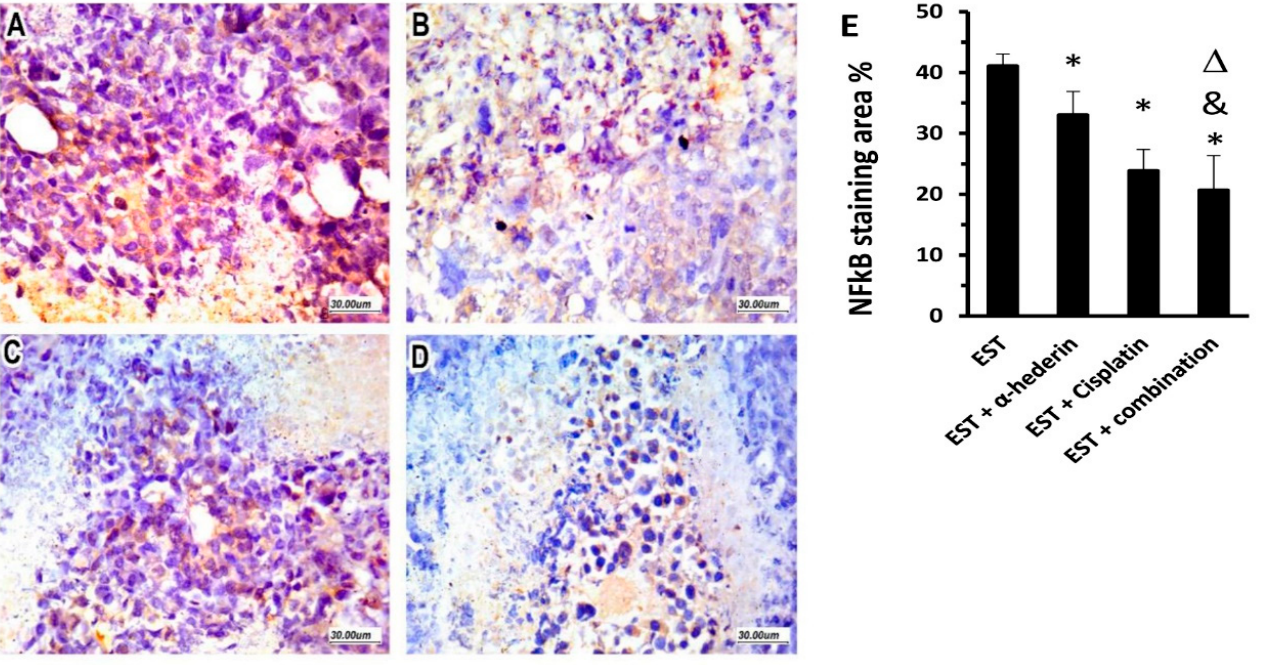
Figure 6. Immunostaining for NF κ B in the study groups . ( A ) Photomicrograph from the EST control group shows marked expression of NF κ B by tumor cells. ( B ) The cisplatin group showed lower expression of NF κ B by tumor cells. ( C ) This image shows the EST + α -hederin group with a moderate expression of NF κ B by tumor cells with areas of necrosis. ( D ) The combination group, showing lower expression. ( E ) column chart for the staining area %. EST: Ehrlich solid tumors. *: versus EST control group, &: versus EST + α -hederin group, ∆ : versus EST + cisplatin group. Data are mean ± SD and were compared at p < 0.05.